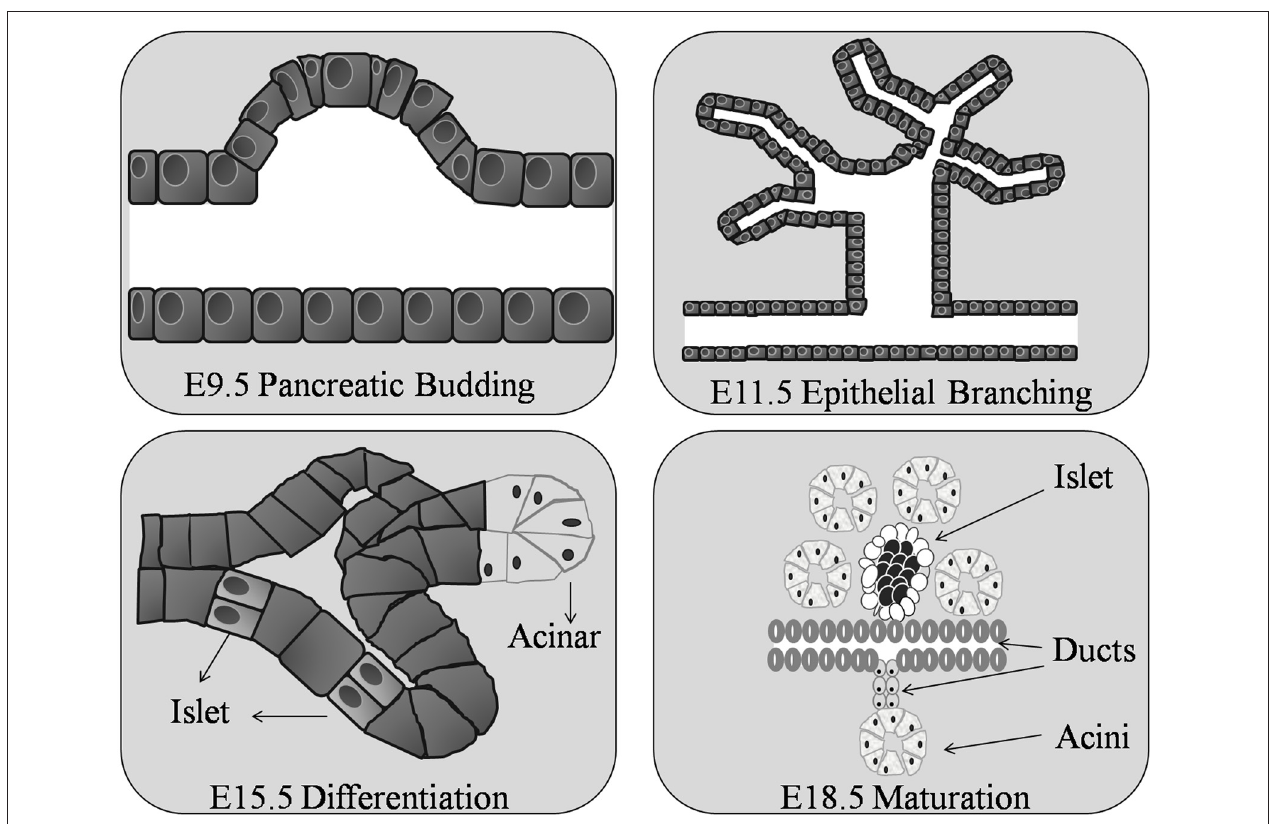
FIGURE 2 | Organogenesis of the murine pancreas. The pancreatic bud begins around day 9 of gestation (E9.5) in the mouse embryo. At E11.5 the pancreatic ductal epithelium grows and branches into the